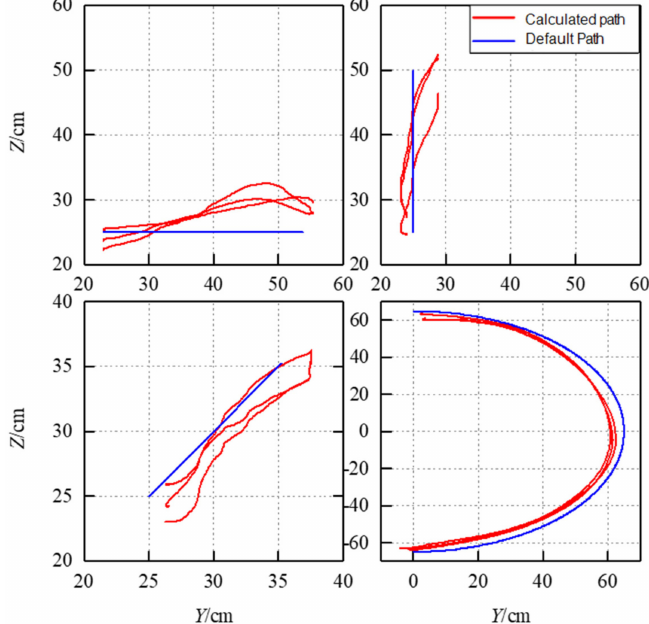
Figure 10. Comparison results of solution trajectory and preset trajectory.